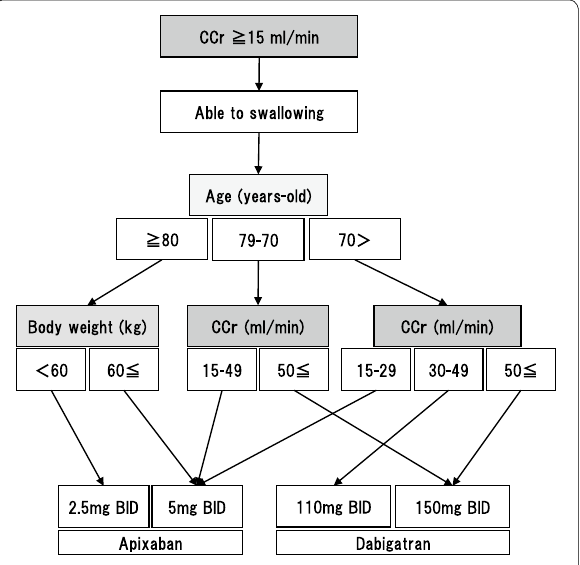
Fig. 2 The algorithm of selection of non-vitamin K antagonist oral anticoagulant (NOAC). This arm is used when a patient prefer a medi- cine twice a day administration. A patient with poor kidney function (CCr < 15 ml/min) cannot apply this algorithm. If a patient shows dys- phagia, a NOAC which can be pulverized is considered for prescrip- tion. CCr creatinine clearance, BID twice a day oral